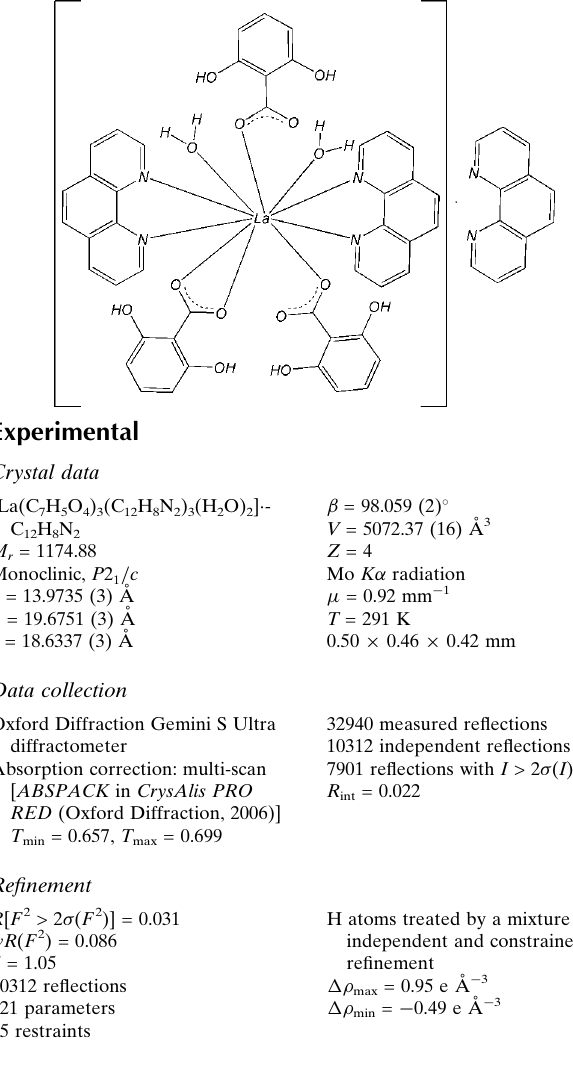
Absorption correction: multi-scan [ ABSPACK in CrysAlis PRO RED (Oxford Diffraction, 2006)] T min = 0.657, T max = 0.699